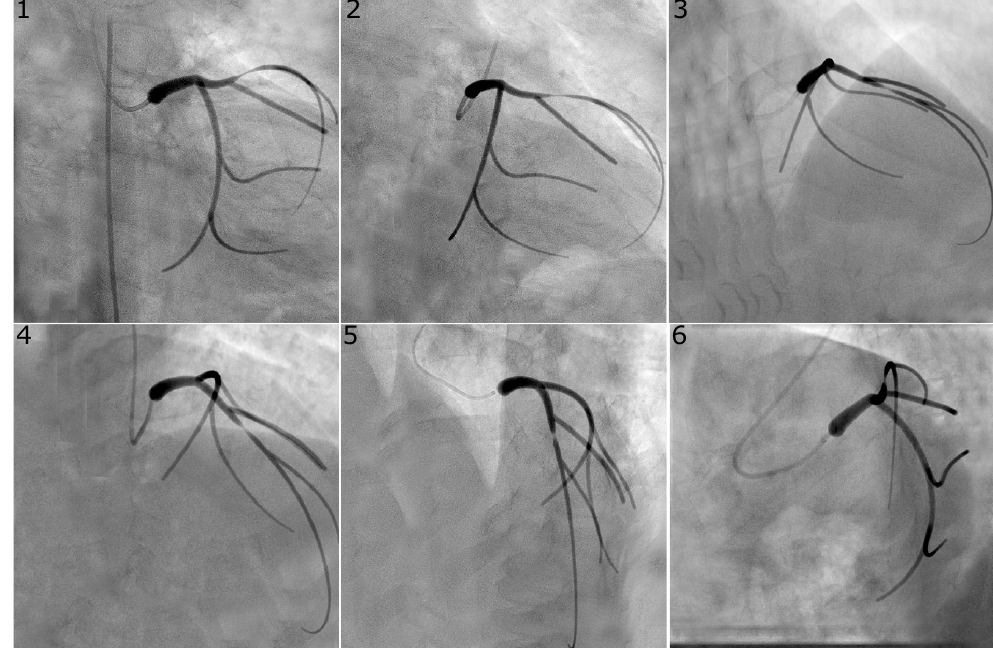
Figure 3. Virtual angiogram for all views of the left coronary system with an eccentric stenosis of type “8040” in the LAD. Views 3 , 4 , and 5 were used to reconstruct this vessel as they are usually selected in the catheterisation laboratory since they avoid vessel overlap and excessive foreshortening for the vessel of